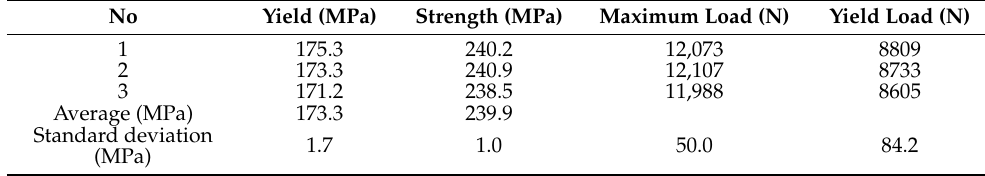
Table 6. Tension test results of steel plate.